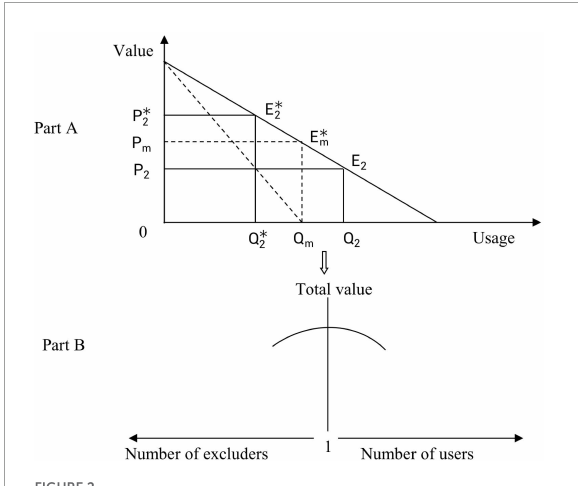
FIGURE2 The symmetry between the commons and the